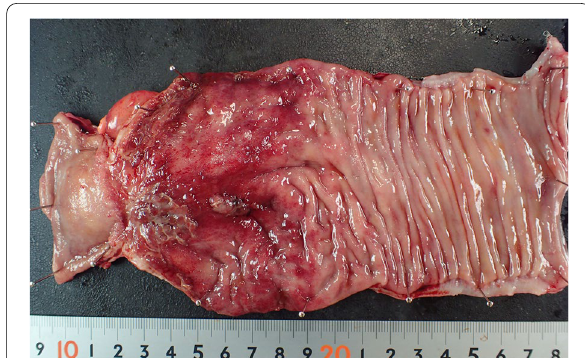
Fig. 4 Macroscopic findings show a thickened wall, circumferential ulceration with scarring and redness of the mucosa, which is consistent with the segment of the stricture